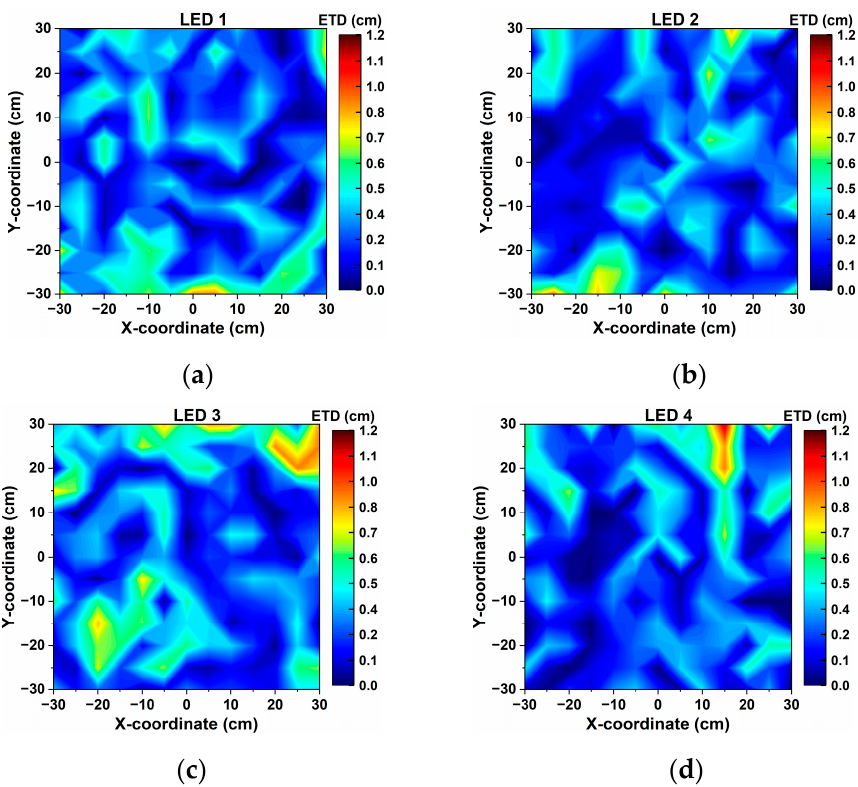
Figure 11. The RSS distributions of ( a ) LED 1, ( b ) LED 2, ( c ) LED 3, and ( d ) LED 4.